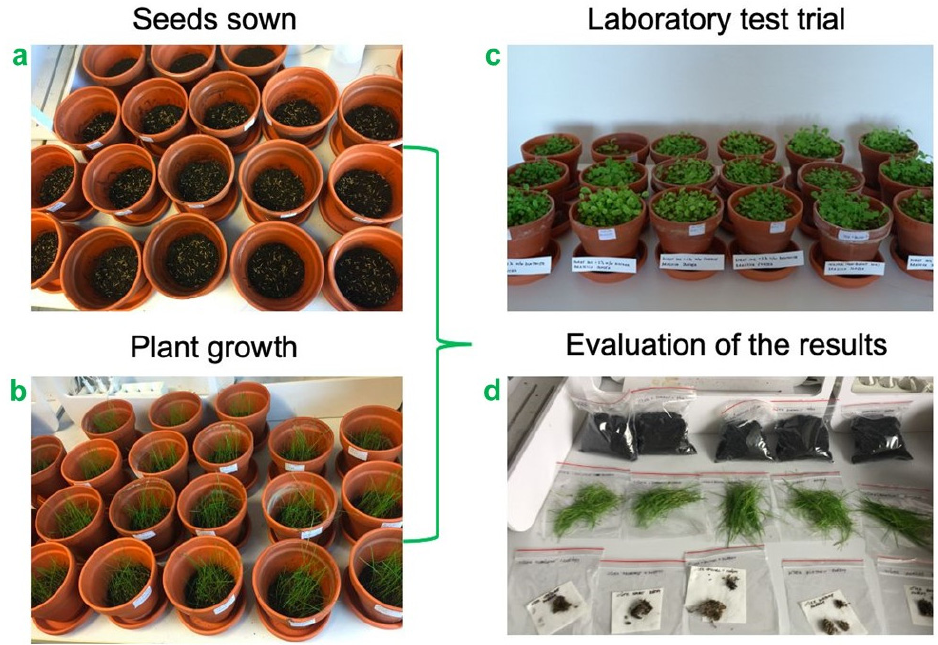
Figure 2. Design of laboratory experiment. ( a ) Beginning of the pot experiment—seeds sown into prepared amended burnt soil; ( b ) Growth of Festuca rubra L.; ( c ) Pot experiment after 40 days ( Brassica juncea L.); ( d ) Separated aboveground and underground biomass. Dimensions of the used